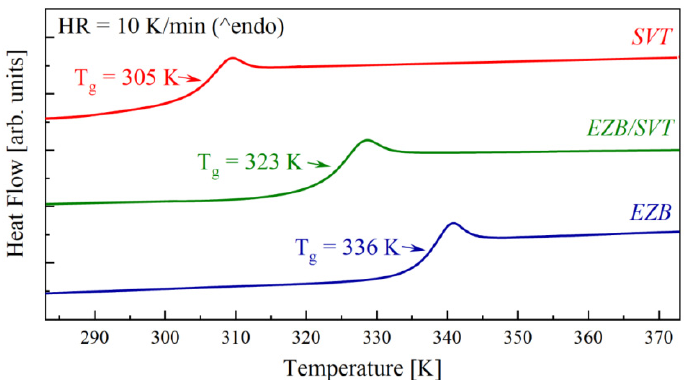
Figure 2. DSC thermograms of quench cooled pure EZB ( blue line), pure SVT ( red line), and EZB/SVT composition ( green line).